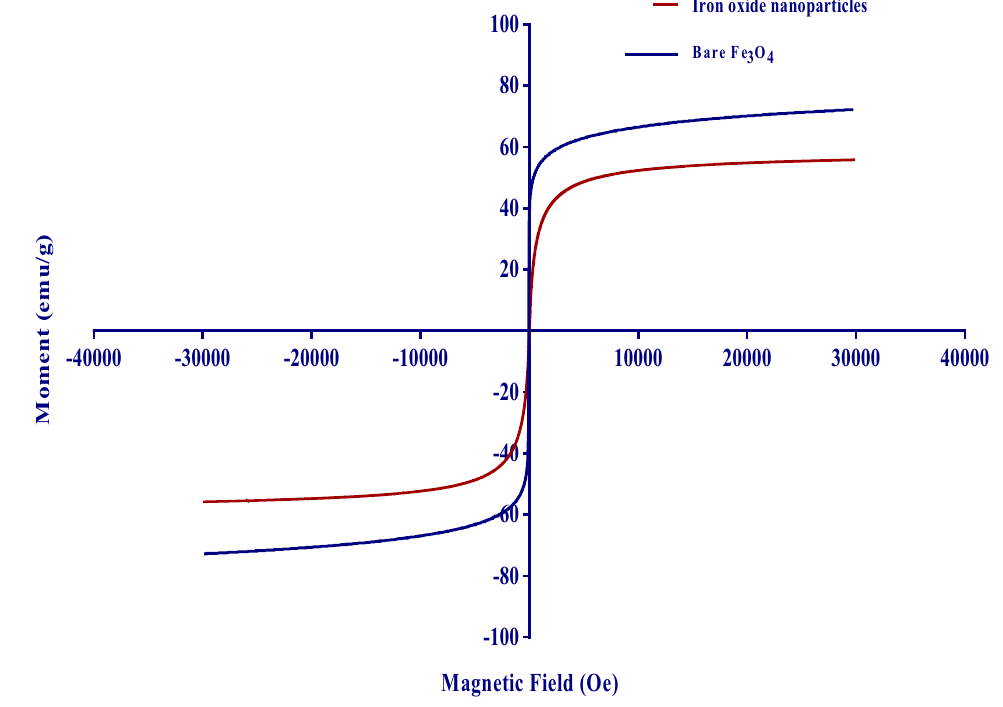
Figure 9. VSM curves for the prepared iron oxide nanoparticle and bare Fe 3 O 4